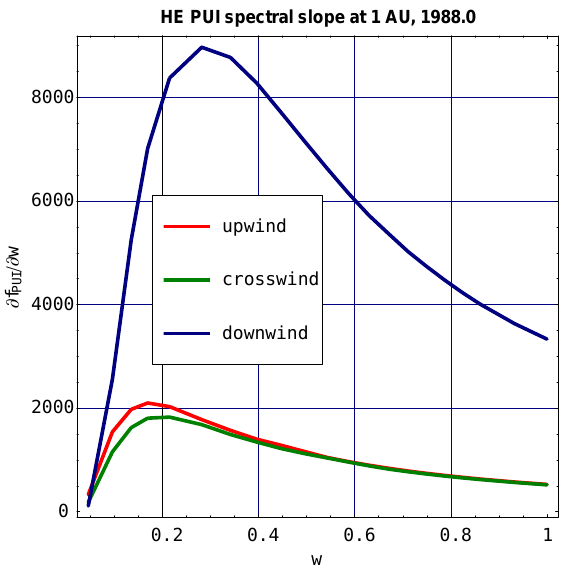
Fig. 20. Slopes of f PUI at four different phases of the solar cycle at 1 AU, crosswind position; w = v/V is speed normalized to solar wind